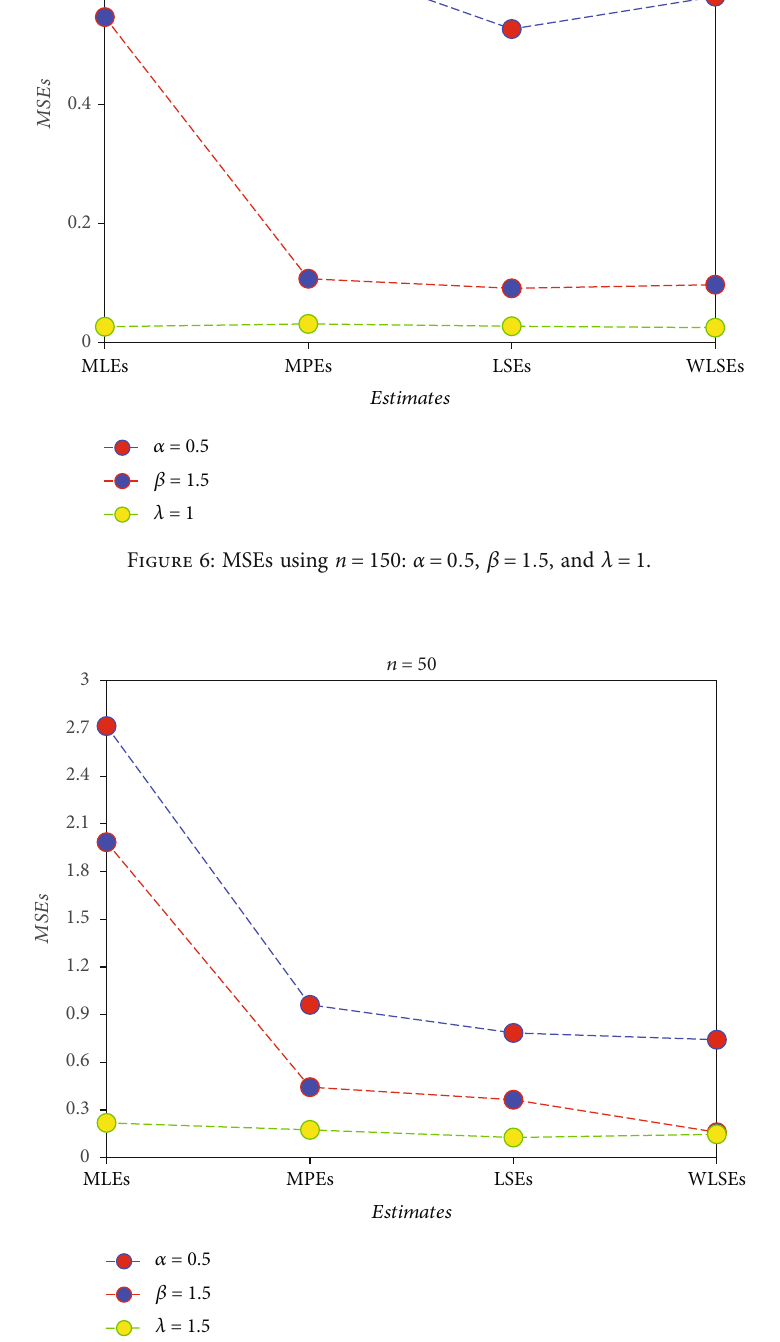
Figure 7: MSEs using n = 50 : α = 0 : 5 , β = 1 : 5 , and λ = 1 : 5